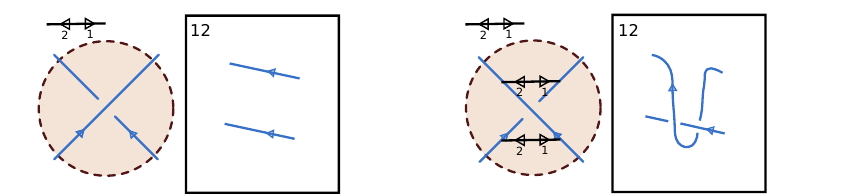
] = (cid:0) q (cid:0) 1 [ e l 4 ]. B B